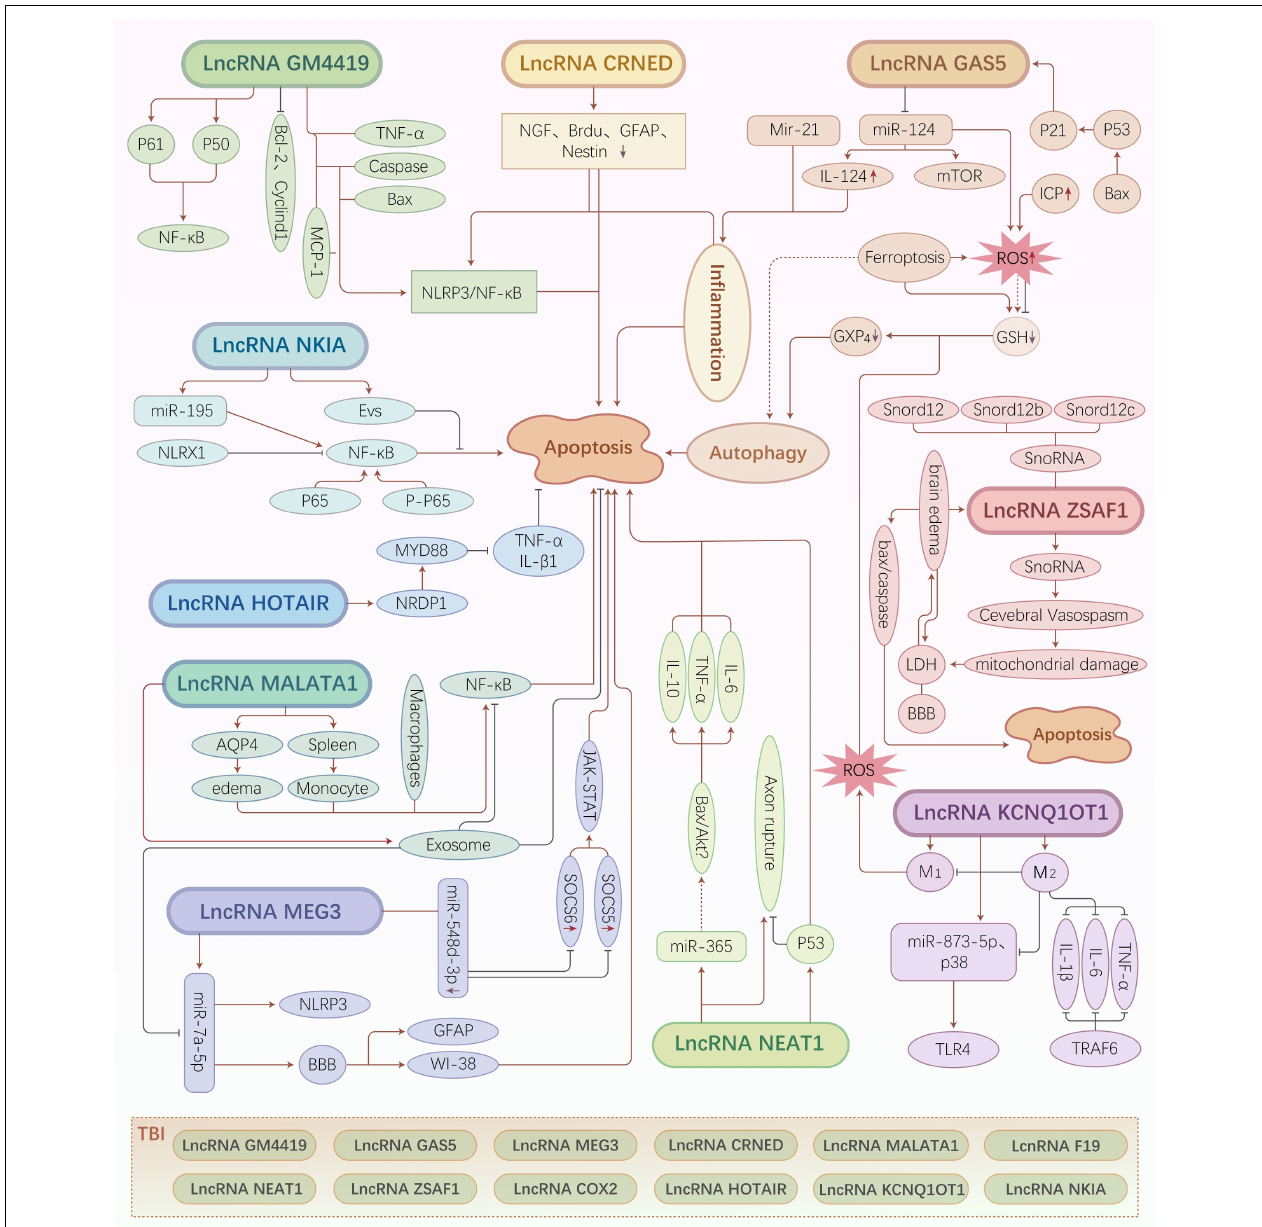
FIGURE 2 | Traumatic brain injury (TBI)-related long non-coding RNA (lncRNA) regulatory mechanisms and pathways. Different types of lncRNAs regulate various downstream molecules that exert neuroprotective or neuroapoptotic effects by inducing cell death pathways, such as inflammatory pathways, oxidative stress, autophagy, and